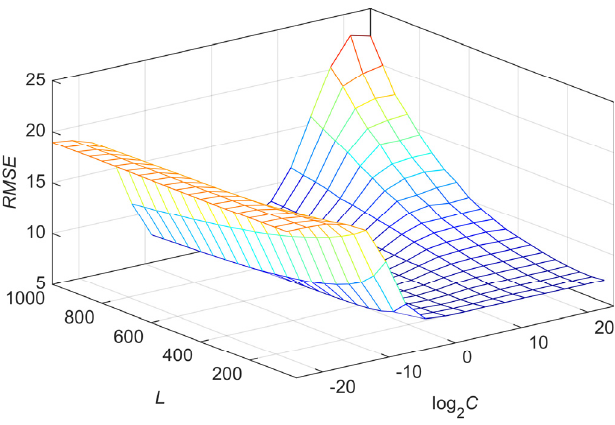
Figure 5. The average validation RMSE with different values of C and L .